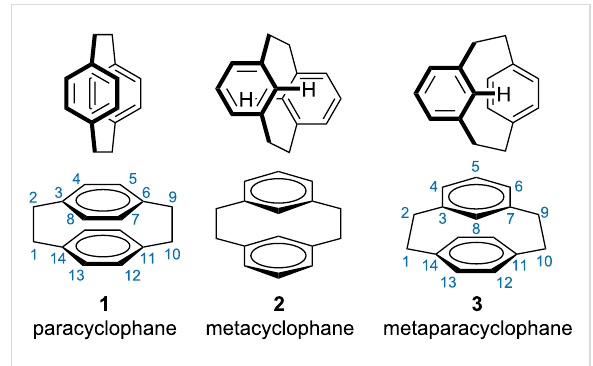
Figure 1: The common